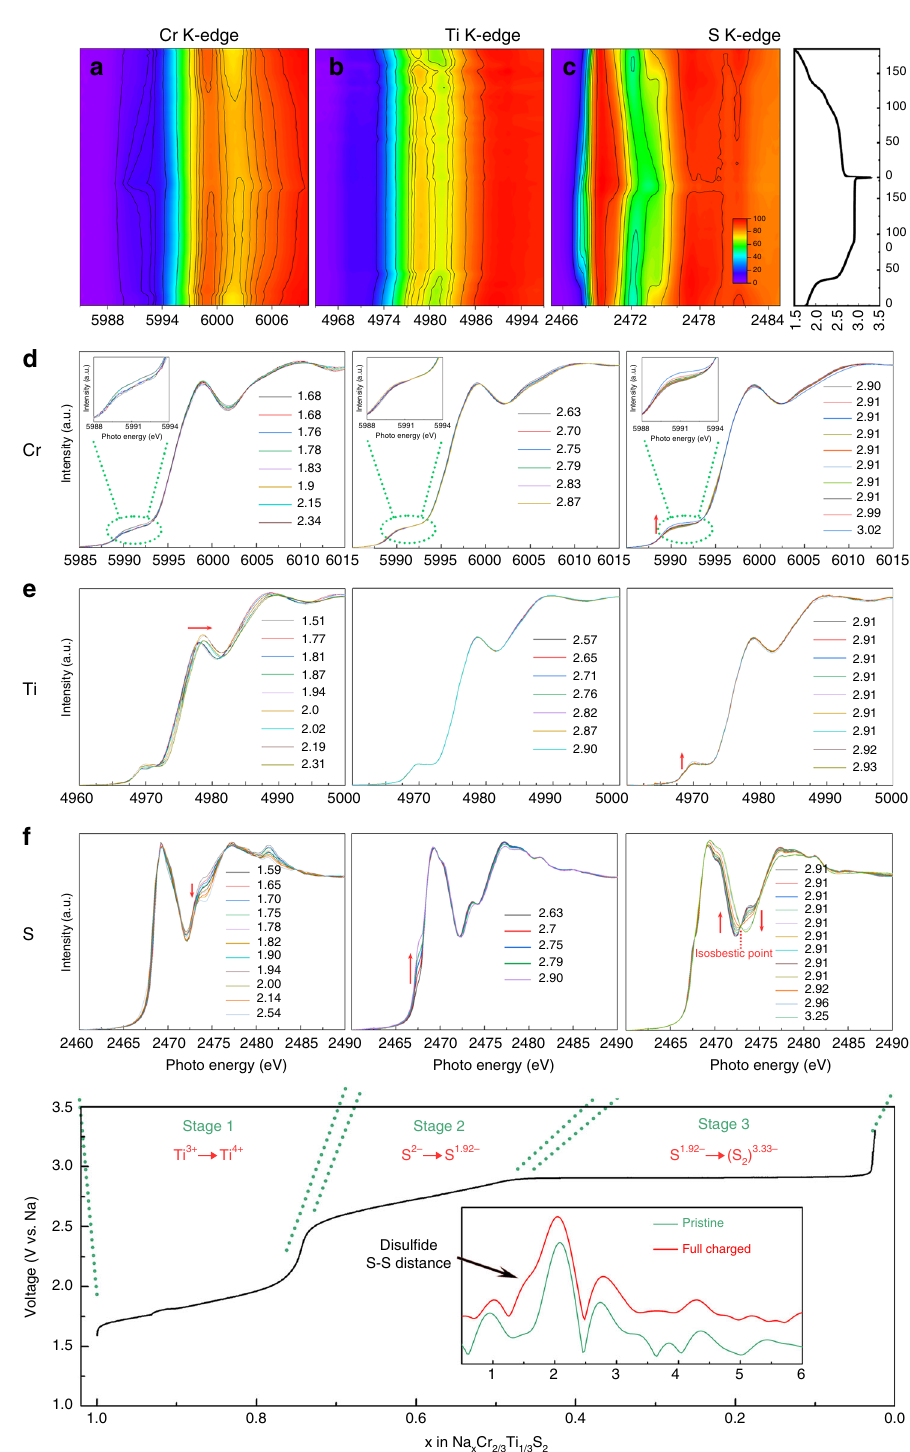
Fig. 3 In situ K-edge X-ray absorption spectroscopy mapping. Mapping of a Cr, b Ti, and c S valance state, the corresponding voltage pro fi les for the fi rst cycle is on the right side. d – f The divided in situ XAS K-edge XAS spectra of three stages as marked in the bottom inset during the fi rst charge process. The inset in the bottom part is converted R space of ex situ sulfur K-edge EXAFS for pristine and full charged samples, showing an embedded peak of disul fi